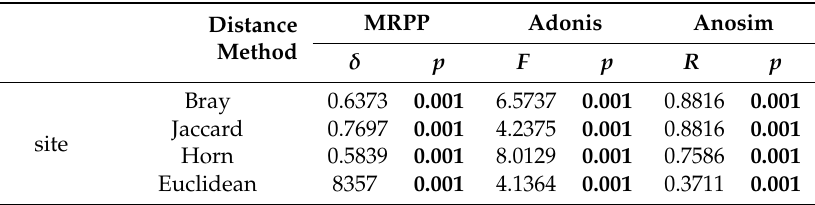
Table 1. Dissimilarity analysis of fungal community structures in di ff erent types of soil. The distance metrics used were Bray, Jaccard, Horn, and Euclidean. Three distance indices were calculated, including mrpp, Adonis, and Anosim. Bolded numbers indicated p values were significant at the 0.05 level. MRPP, Multi Response Permutation Procedure; Anosim, Analysis of similarities.